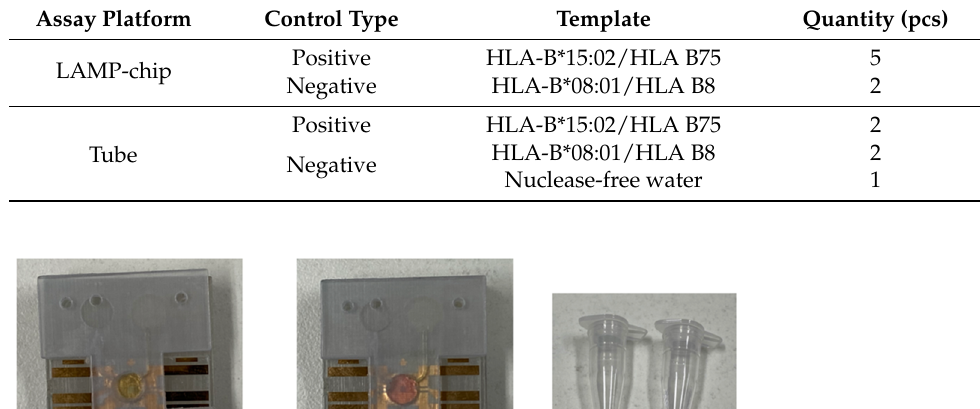
Table 1. LAMP assays on chip and in tube.